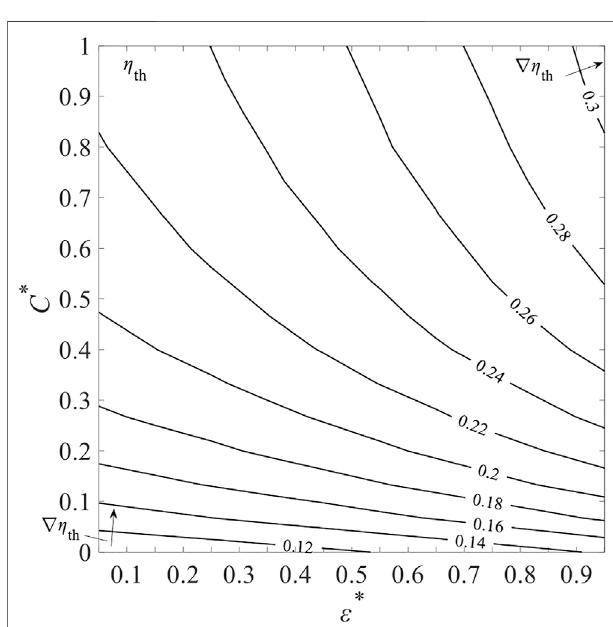
FIGURE 19 | Total solar-to-fuel ef fi ciency, η th , as a function of non- dimensional gas-phase heattransfer effectiveness, ε *, and concentration ratio (cid:2) 0.01. C * at fi xed T red (cid:2) 1900 K and p O 2